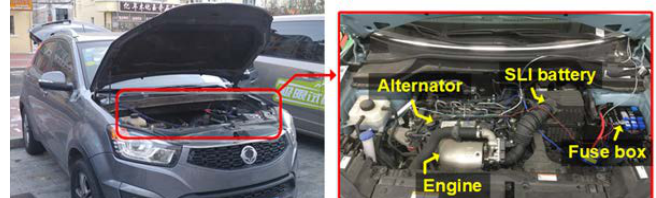
Figure 13. SLI battery used in experimental verifications: ( a ) SLI battery pack; ( b ) Internal structure and BMS board.